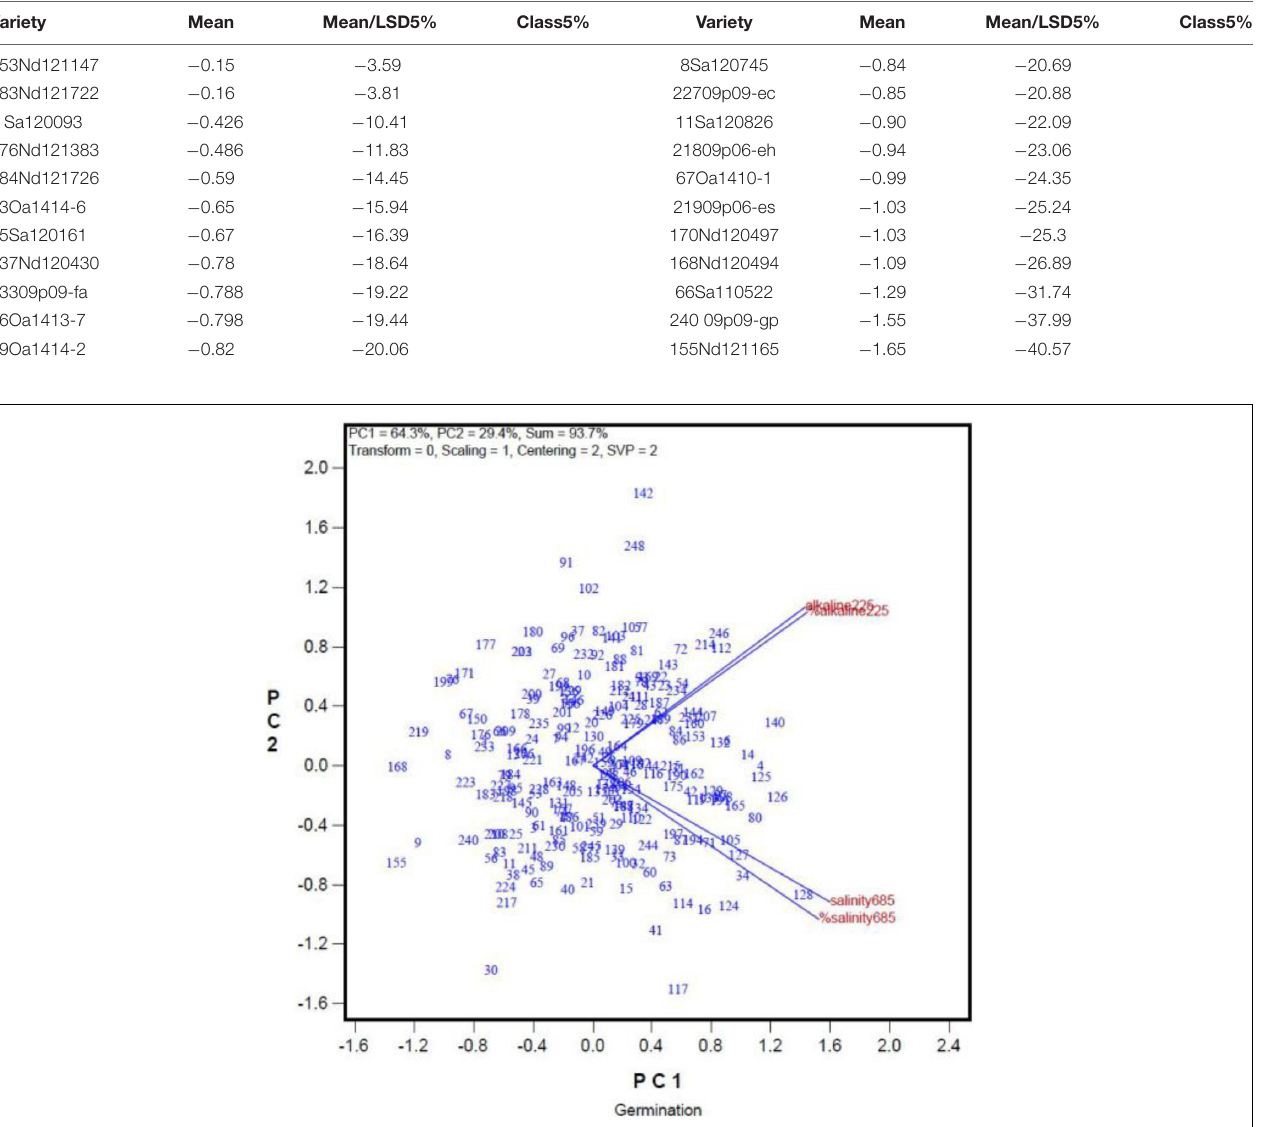
FIGURE 3 | Relationship among germination rates under a salt stress and alkali stress across genotypes. The germination rate was represented both in number of germinated seed and in percentage of the control.